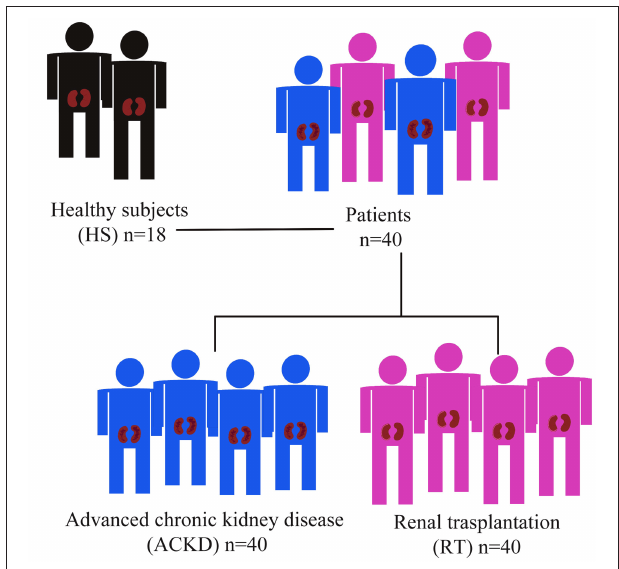
FIGURE 1 | Description of cross-sectional study